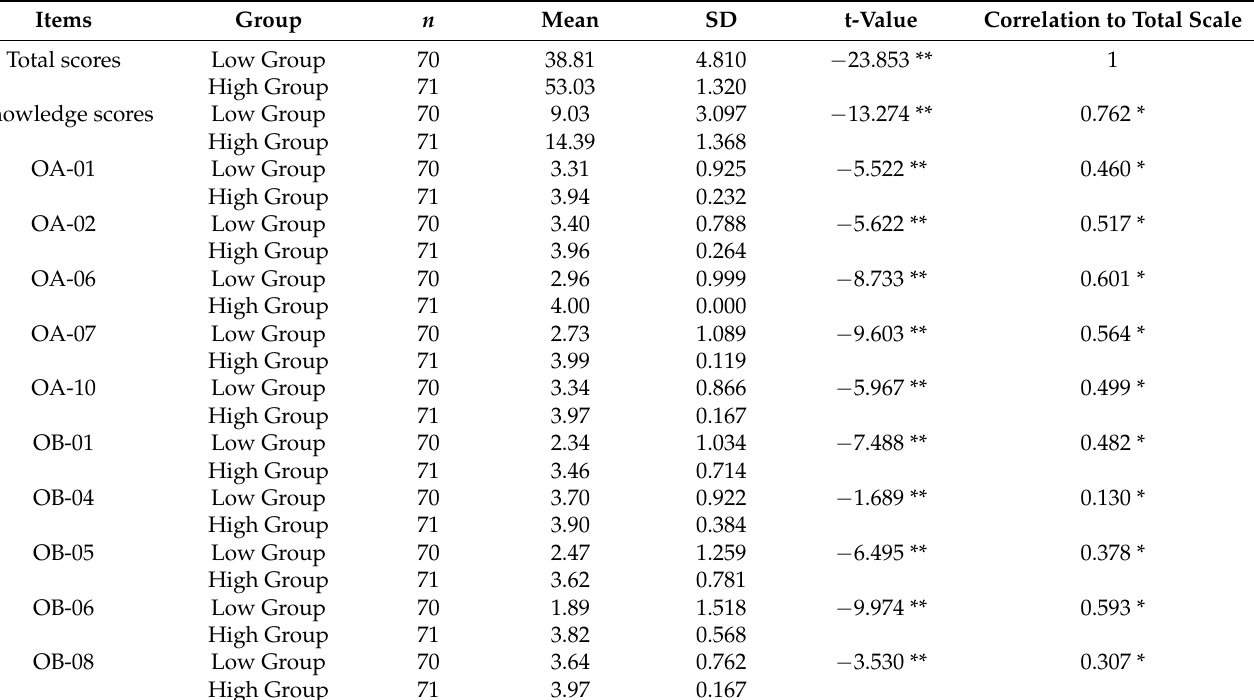
Table 2. Descriptive statistics of total scores and subscales, mean differences between high and low groups of total score ( n = 262).